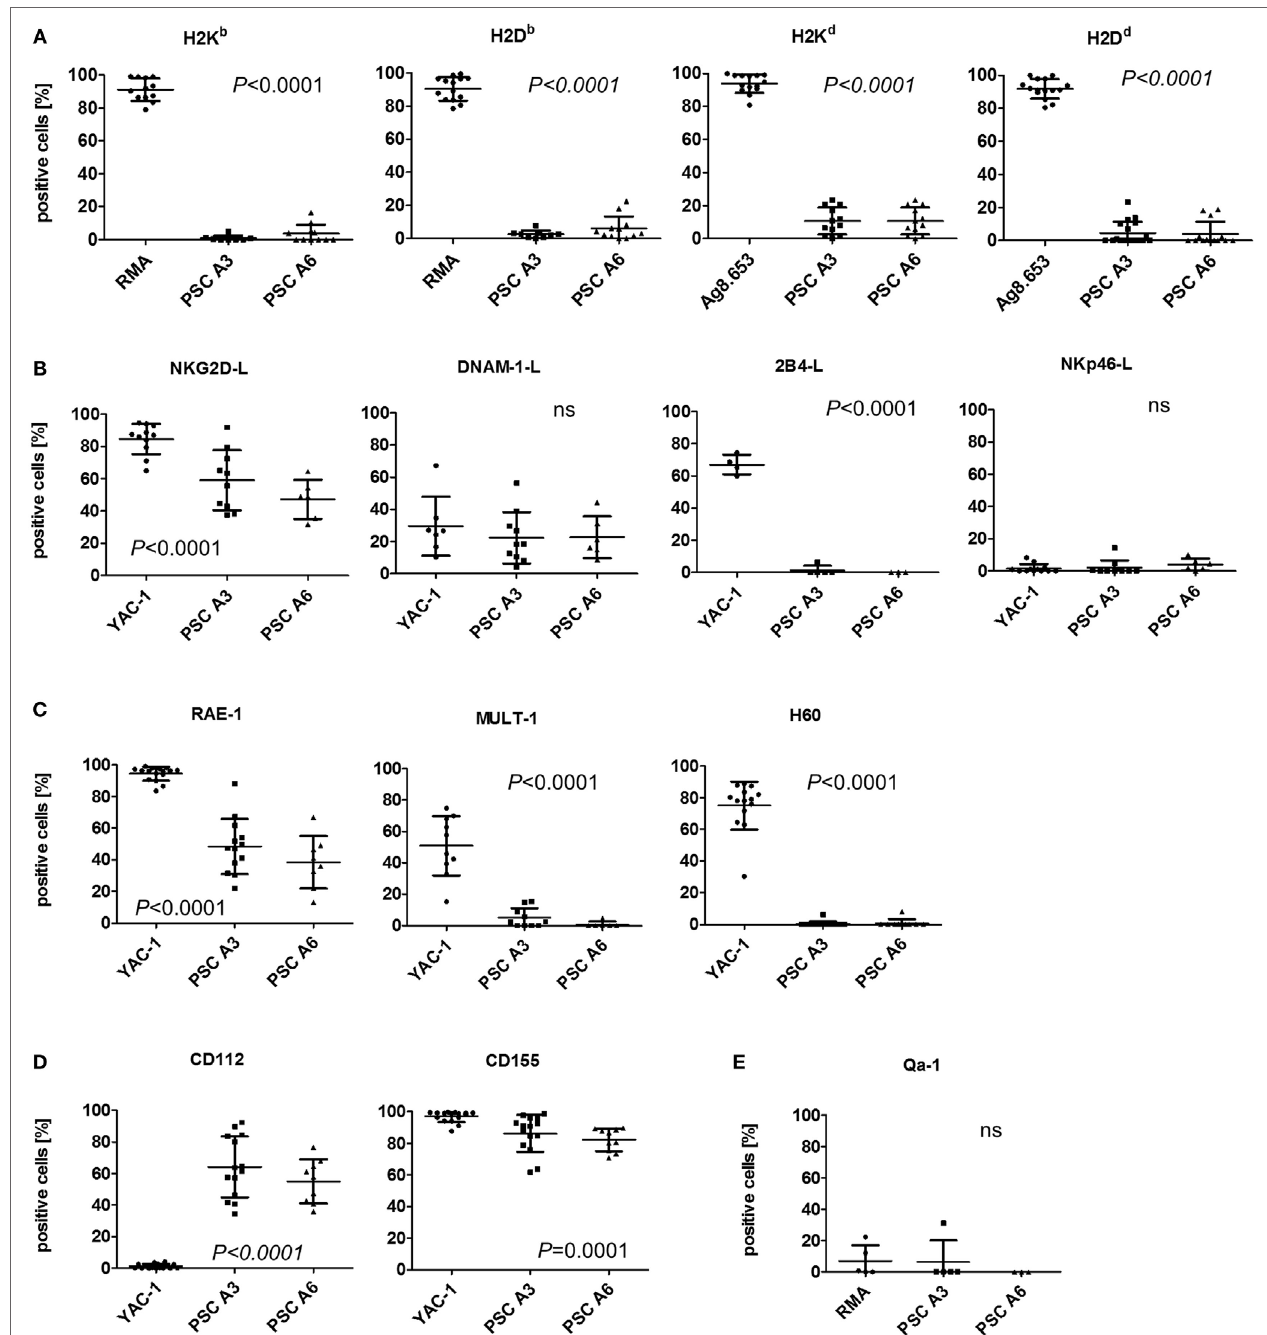
FigUre 3 | Analysis of the expression of natural killer (NK) receptor ligands on parthenogenetic stem cell (PSC) A3, PSC A6, and control cells. The percentage of cells expressing the indicated NK receptor ligands is shown as determined by flow cytometry in 3–18 individual experiments. In addition, the mean ± SD is indicated. Differences between the three cell lines were analyzed by Kruskal–Wallis tests and the respective P -values or non-significant (ns) results are indicated. (a) The expression of classical major histocompatibility complex (MHC) class I molecules, which can serve as ligands for inhibitory NK receptors has been determined by allotype-specific monoclonal antibodies. RMA (H2 b ) or Ag8.653 (H2 d ) cells served as positive controls. (B) The expression of ligands of the activating NK receptors NKG2D, DNAM-1, 2B4, and NKp46 on the PSCs in comparison to YAC-1 cells has been tested by binding of recombinant receptor-Fc fusion proteins. (c) The presence of the NKG2D receptor ligands RAE-1, MULT-1, and H60 has been analyzed in comparison to YAC-1 cells. (D) The expression of DNAM-1 receptor ligands CD112 and CD155 has been tested in comparison to YAC-1 cells. (e) The expression of the non-classical MHC class I molecule Qa-1, which is a murine functional homolog of human leukocyte antigen-E has been determined in comparison to RMA cells.